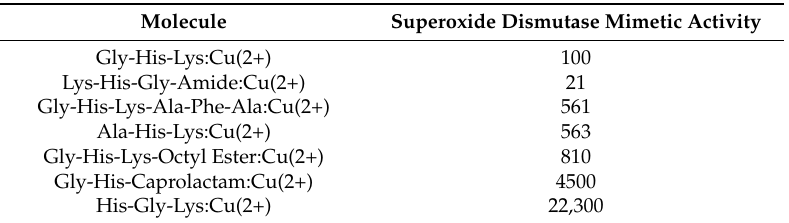
Table 4. Superoxide Dismutase Mimetic Activity of GHK and